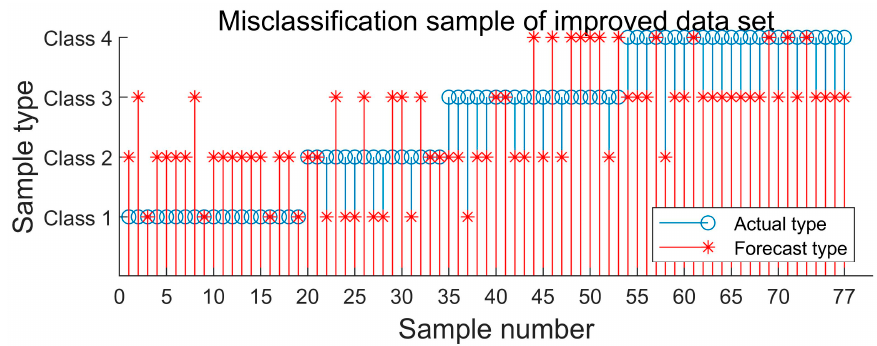
Figure 12. Classification results of misclassified samples in one-vs-all classification SVM.